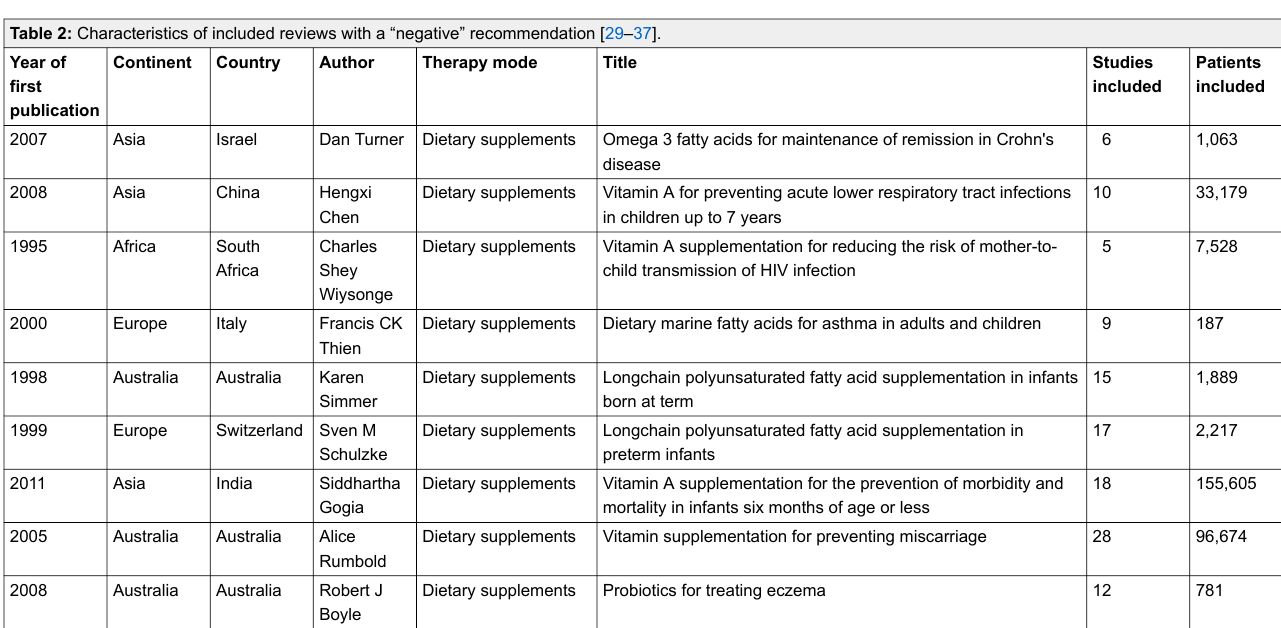
Origin of Cochrane reviews by country.